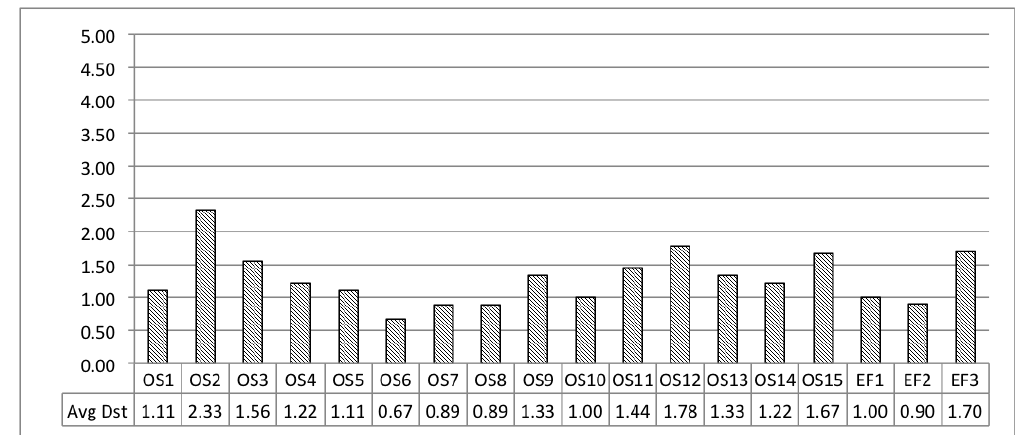
Figure 8. Satisfaction questionnaire distances